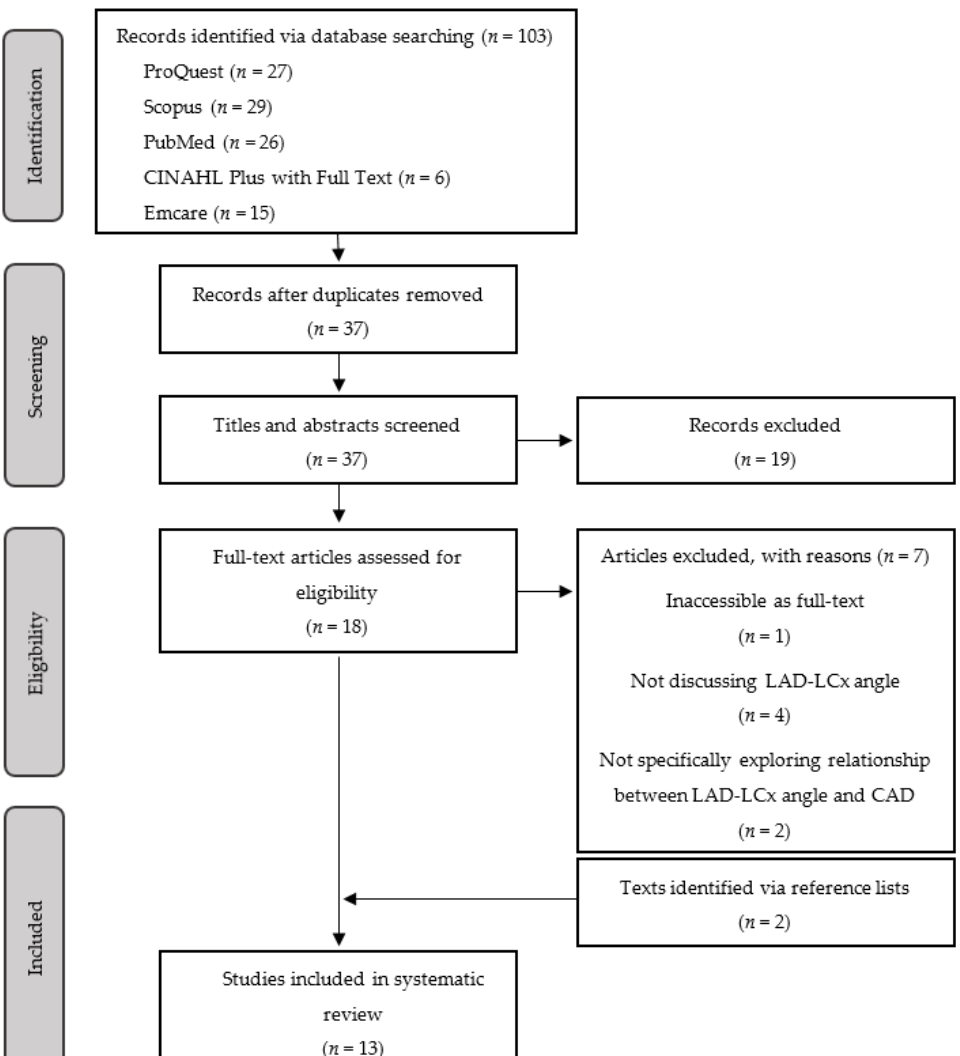
Figure 3. PRISMA flow diagram to search for relevant studies.